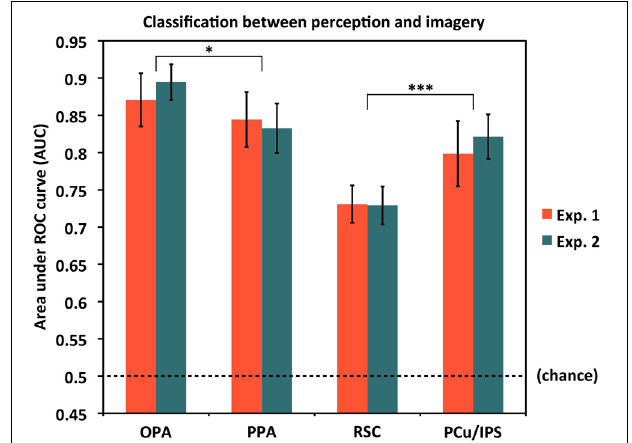
FIGURE 5 | Classification accuracy for distinguishing between the overall processes of perception and mental imagery by ROI. In all cases, accuracies were significantly above chance (AUC = 0.5), but there were significant differences in accuracy by region. OPA differentiated between perception and imagery the best, followed by PPA, PCu/IPS, and RSC. Pairwise comparisons between OPA and PPA, and between PCu/IPS and RSC, were significant, though PPA and PCu/IPS did not significantly differ. Analyses used 80 voxels per hemisphere per region, for a total of 160 voxels per region. ∗ p < 0 . 05, ∗∗∗ p < 0 . 001. Error bars represent s.e.m. See text and Table 1 for full